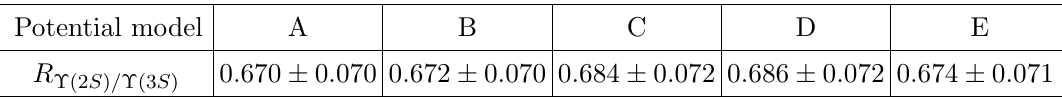
, where the binding energies are computed within the (cid:7)(2 S ) = (cid:7)(3 S )